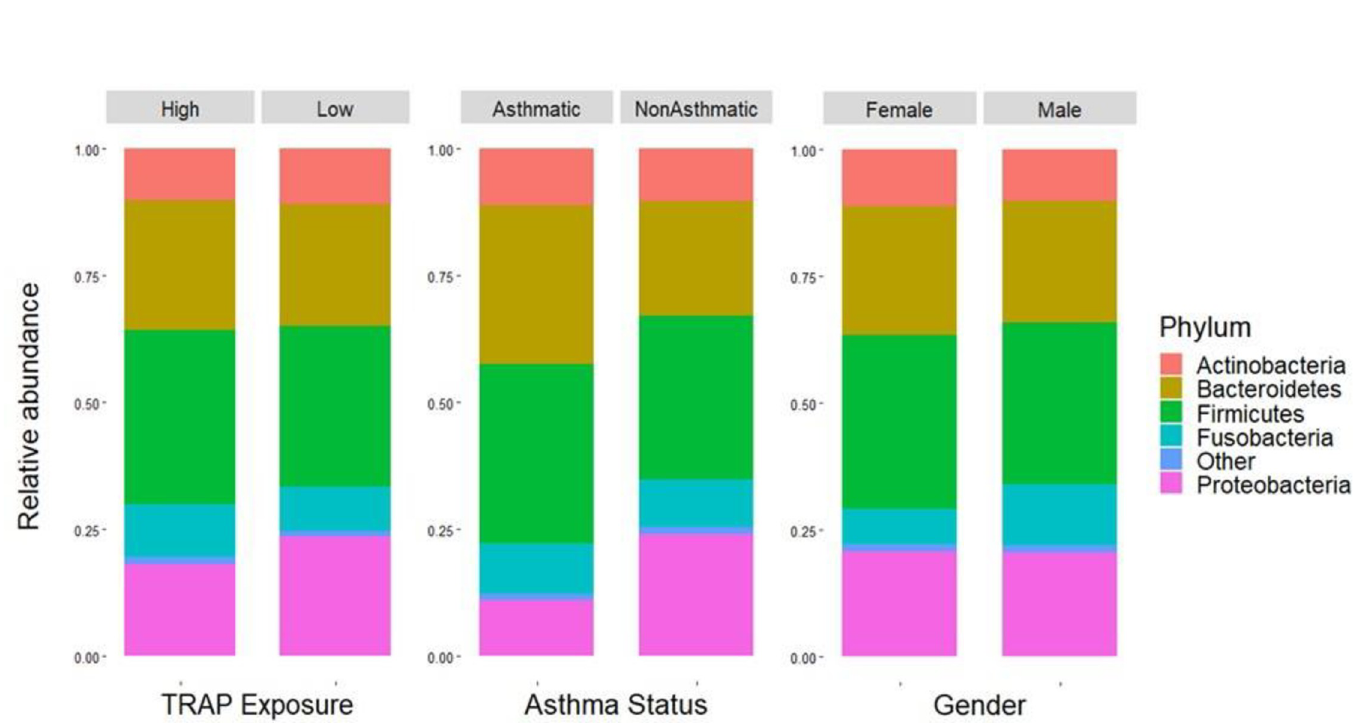
Fig 5. Bar plots showing the relative abundance of bacterial phyla in sputum across (A) TRAP exposure groups, (B) asthma status groups, and (C) genders.